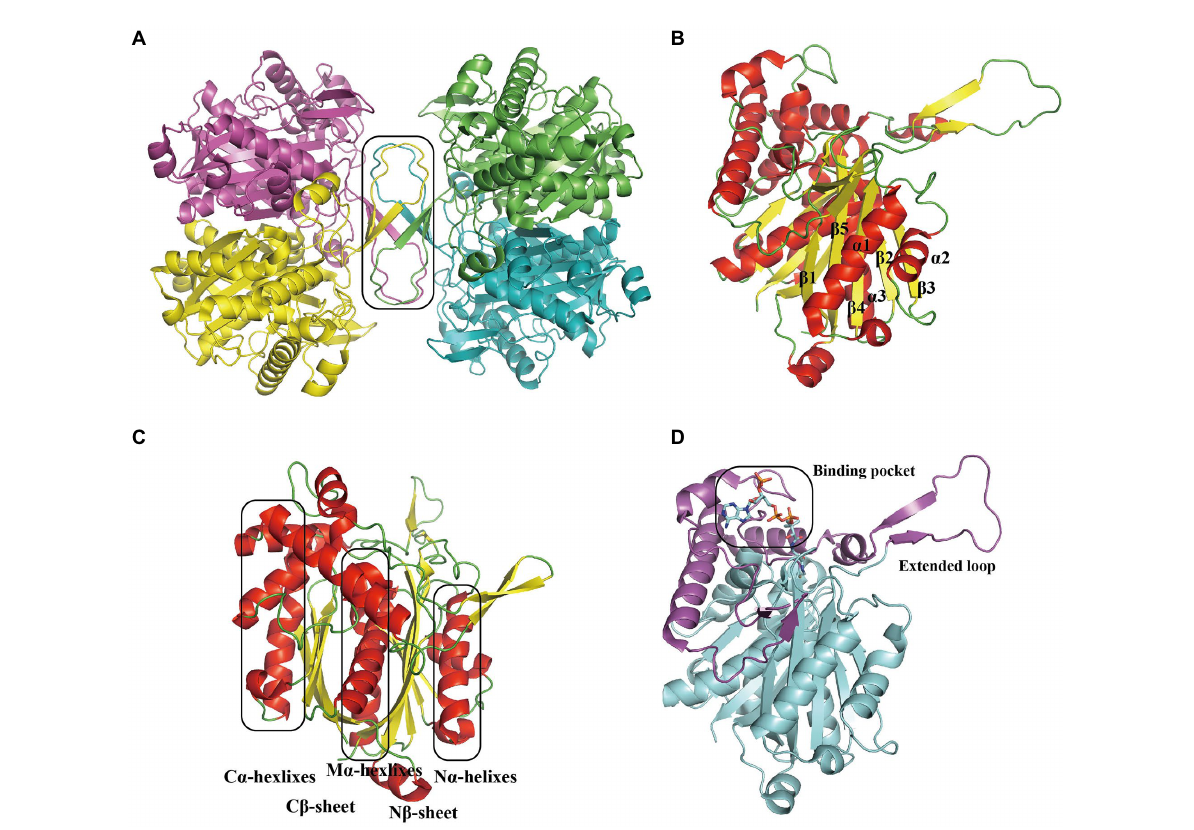
FIGURE 9 Overall structure of PaaJ. (A) The overall structure of TthPaaJ (PDB: 1ULQ) reveals a tetramer shown in a different color for each chain with two lobes and a central β -barrel composed of four monomers circled with a solid line. (B) The PaaJ monomer is colored by secondary structure, red, yellow, and green for the α -helix, β -strands, and loop, respectively. The N-terminal and C-terminal region reveals a similar βαβαβαβ topology (the secondary structure elements in the N-terminal are annotated). (C) The rotated view in (B) , reveals a sandwich architecture where the N-terminal and C-terminal β -sheet are covered by two-layer α -helices. N, C and M for N-terminal, C-terminal and medial, respectively. (D) The extended loop domain between N β 4 and N β 5 in the N-terminal β -sheet is involved in CoA binding. The loop is shown in magenta while the rest is in cyan, and the binding pockets are circled with a solid